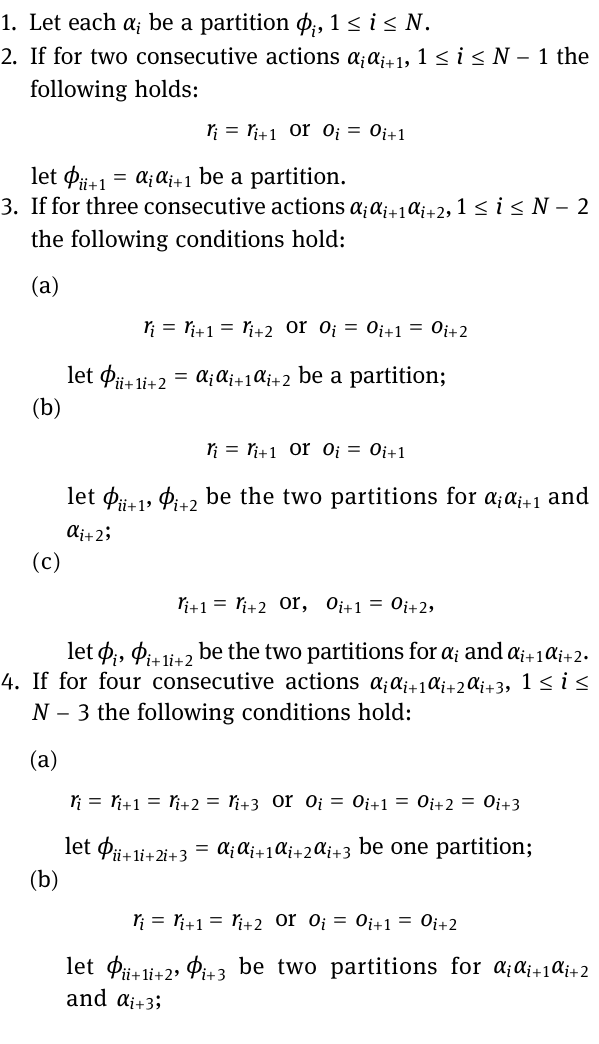
Algorithm 1 returns the set of all partitions for a given instantiation. The algorithm is similar to the Cocke – Younger – Kasami algorithm [ 15 ] . It checks for successive substrings α whether the acting robot or the object to be moved